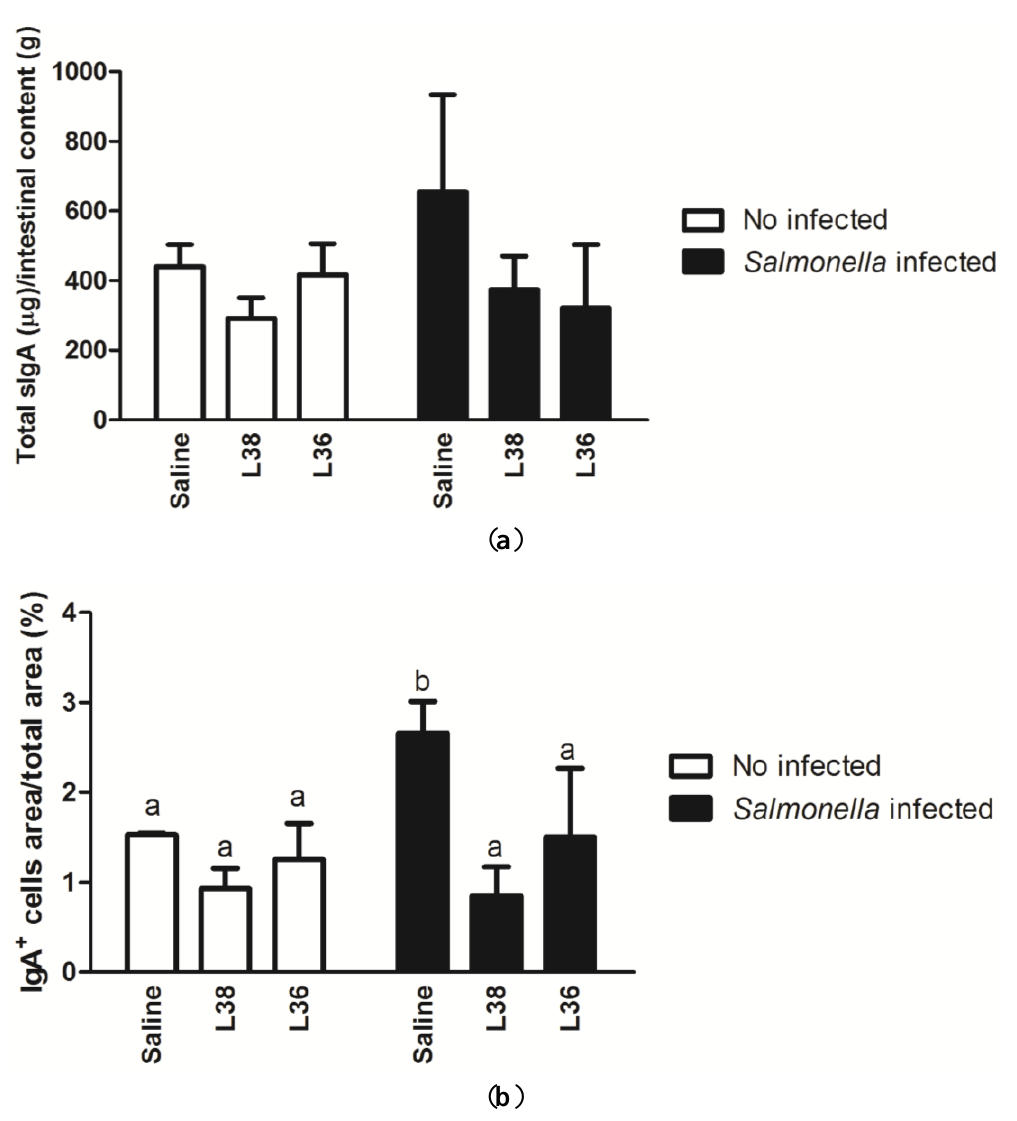
Figure 2. Production of secretory immunoglobulin A (sIgA) in the small intestine of L38- and L36-pretreated mice on the 9th day post -Salmonella challenge. ( a ) sIgA amount in the luminal content; ( b ) proportion of IgA producing (IgA + ) cells area in the ileum. Results are expressed as mean of µg sIgA/g intestinal content and percentage of IgA + cells area/total area ( n = 10 per group). The vertical bars indicate the standard deviation of means. Different letters over the bars indicate statistically significant differences between the experimental groups ( p <